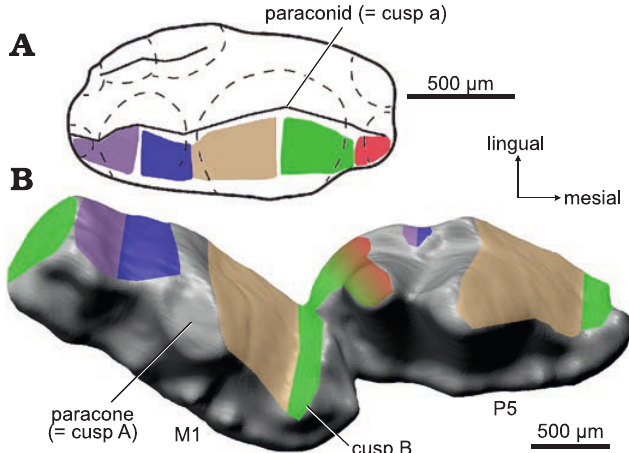
Fig. 7. Hypothetical molar occlusal wear facet pattern in P5–M1 of Cifelli‑ lestes ciscoensis gen. et sp. nov. ( B , OMNH 69352), with illustration of a lower molar modi fied from Morganucodon watsoni Kühne, 1949 ( A , m2, UMZC_Eo.CR.1, reversed). Cor res ponding colors on upper and lower teeth indicate matching wear facets. The occlusal pattern of C. ciscoensis is similar to M. watsoni in that the protoconid (also referred to as cusp a) of the lower molars occludes between the upper molar paracone (also re- ferred to as cusp A) and cusp B, carving a prominent groove between the two cusps. This also results in contact to the next mesial tooth, due to the size of the protoconid. The paracone occludes between the protoconid and metaconid (also referred to as cusp c). Modified after Jäger et al.